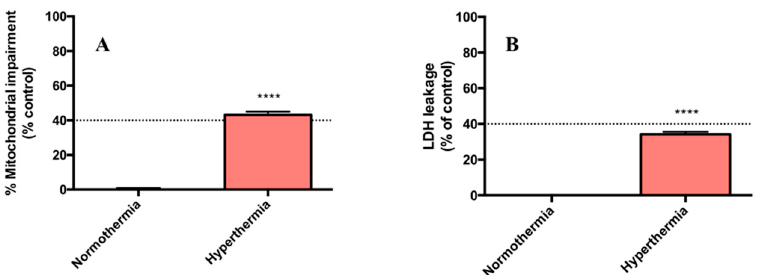
Figure 1. Cell viability measured by ( A ) MTT reduction and ( B ) lactate dehydrogenase (LDH) leakage, 24 h after exposure of primary mouse hepatocytes to normothermic (37 °C) and hyperthermic (40.5 °C) conditions. Results were obtained from 10 independent experiments, performed in triplicate. **** p < 1.00 × 10 –4 (hyperthermic vs. normothermic conditions).